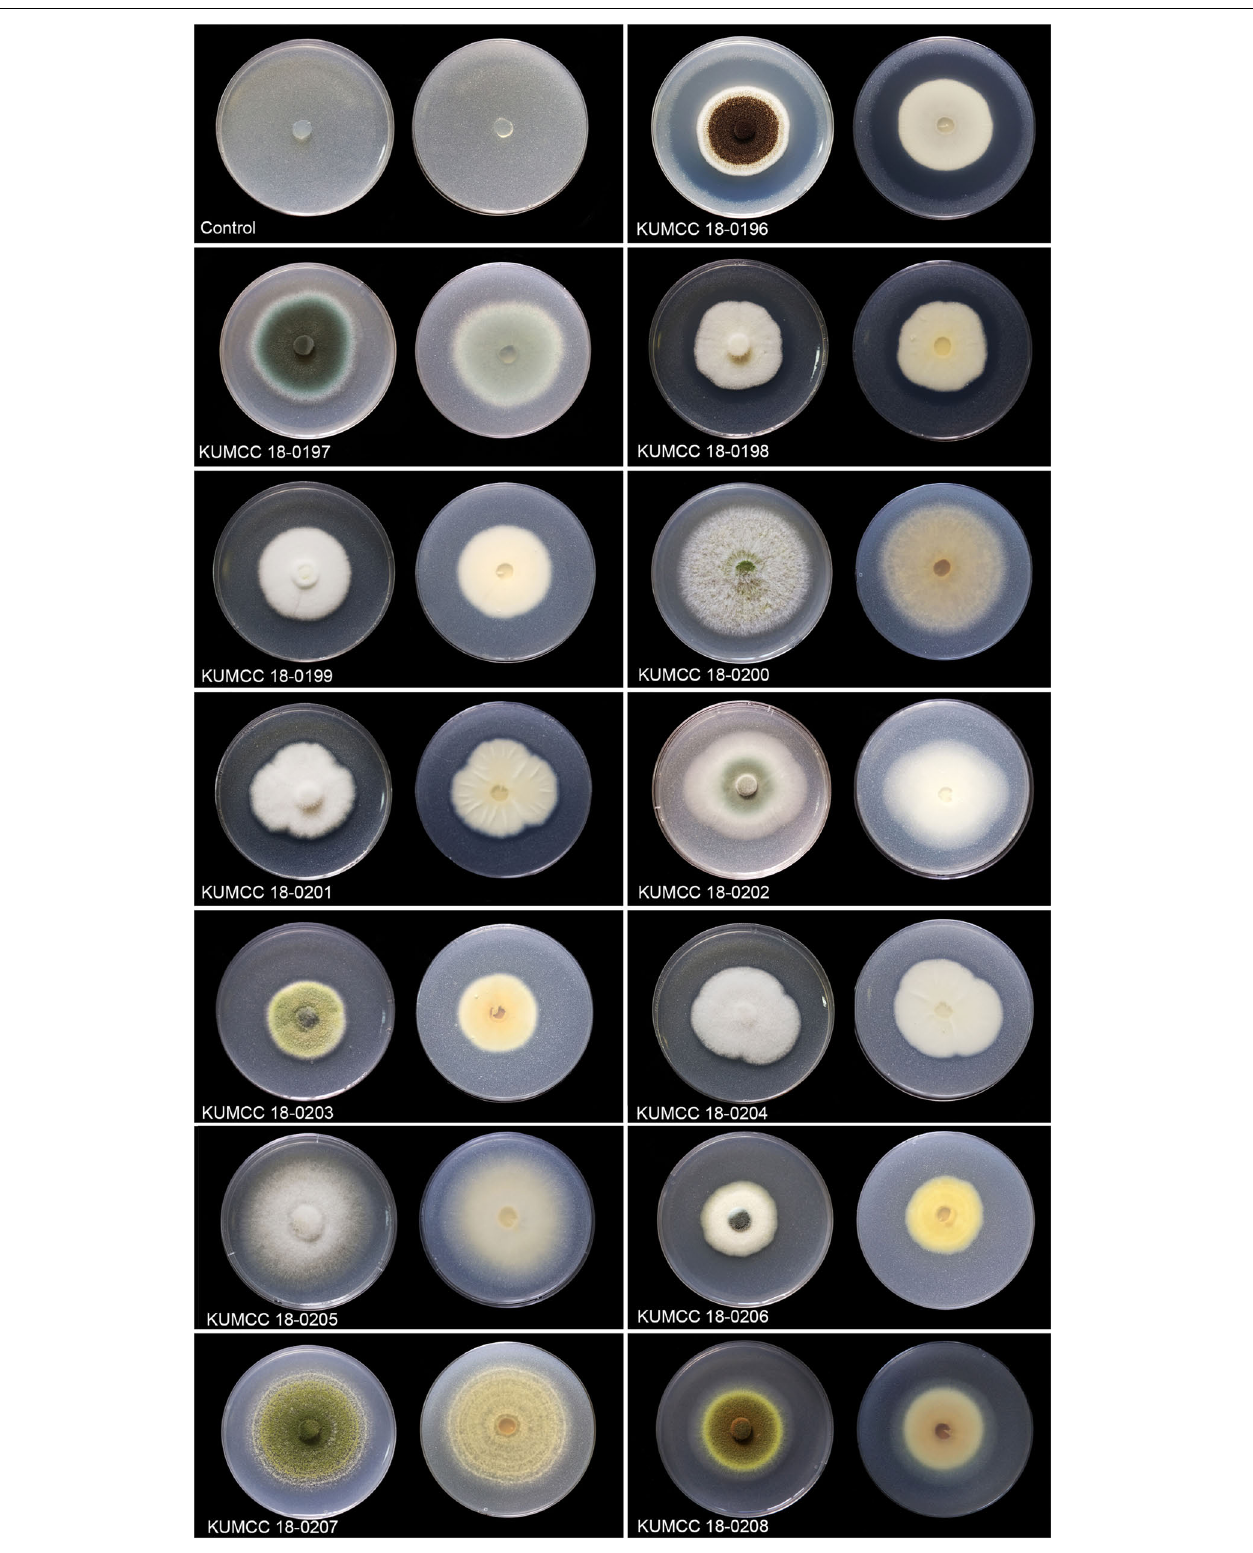
FIGURE 1 | Colony features and clear zones formation for TCP solubilization on PVK agar after 7 days Except isolate KUMCC 18-0196 after 5 days (left = above view, right = below).